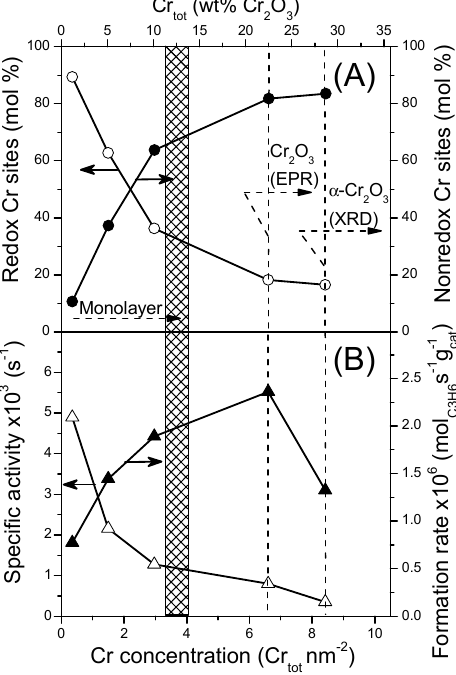
Figure 4. Variation of mole percent of redox and non-redox in origin Cr species ( A ) as well as specific activity and formation rate ( B ) with total Cr concentration. Reaction conditions: T = 550 ◦ C; m cat. = 200 mg; Feed gas composition C 3 H 8 :He =1:14; Total flow rate = 30 cm 3 · min − 1 ; WHSV = 1.2 h − 1 ; Results collected after 10 min-on-stream.